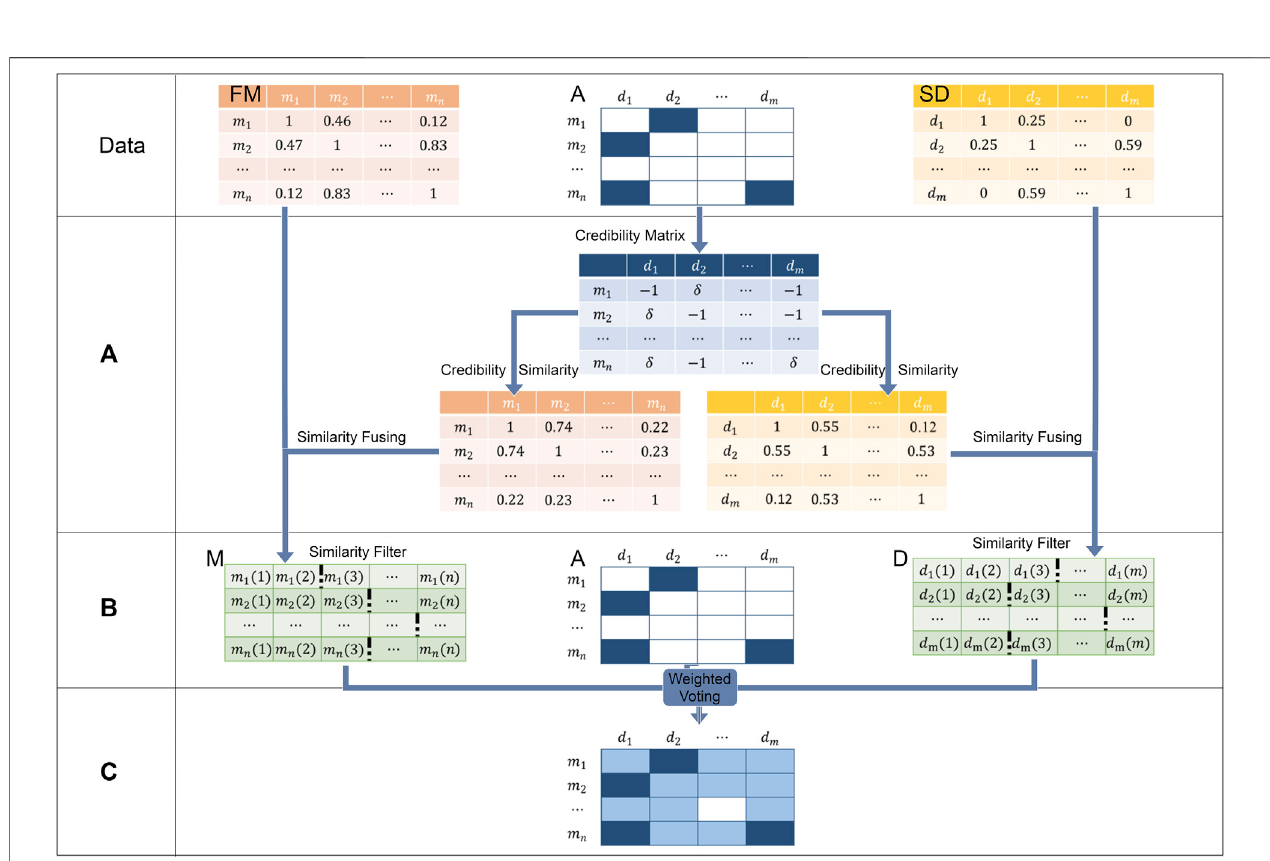
FIGURE 2 | WVMDA can be divided into three steps: (A) we construct the credibility similarity network through known associations, (B) we fi ltered them after combining both similarity, and (C) weighted voting is used as the predictive model.